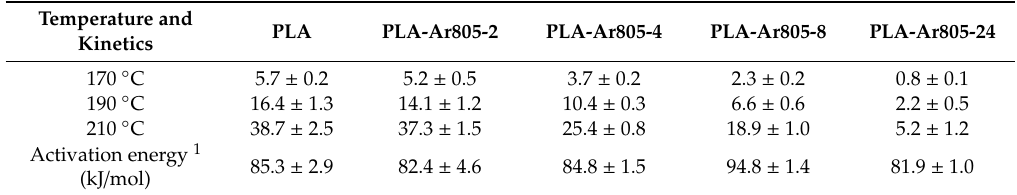
Figure 1. FESEM images of the fracture surface of polylactic acid (PLA)-based nanocomposites with 1, 2, 8, and 16 vol% of fumed silica. Table 1. Melt flow index (at 2.16 kg) and activation energy of PLA-based nanocomposites at di ff erent